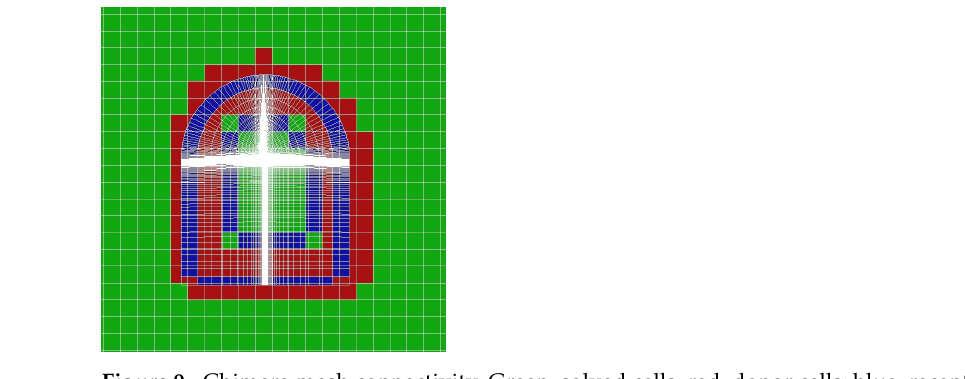
Figure 9. Chimera mesh connectivity. Green, solved cells; red, donor cells; blue, receptor cells. On the component mesh, only the receptor cells are indicated.